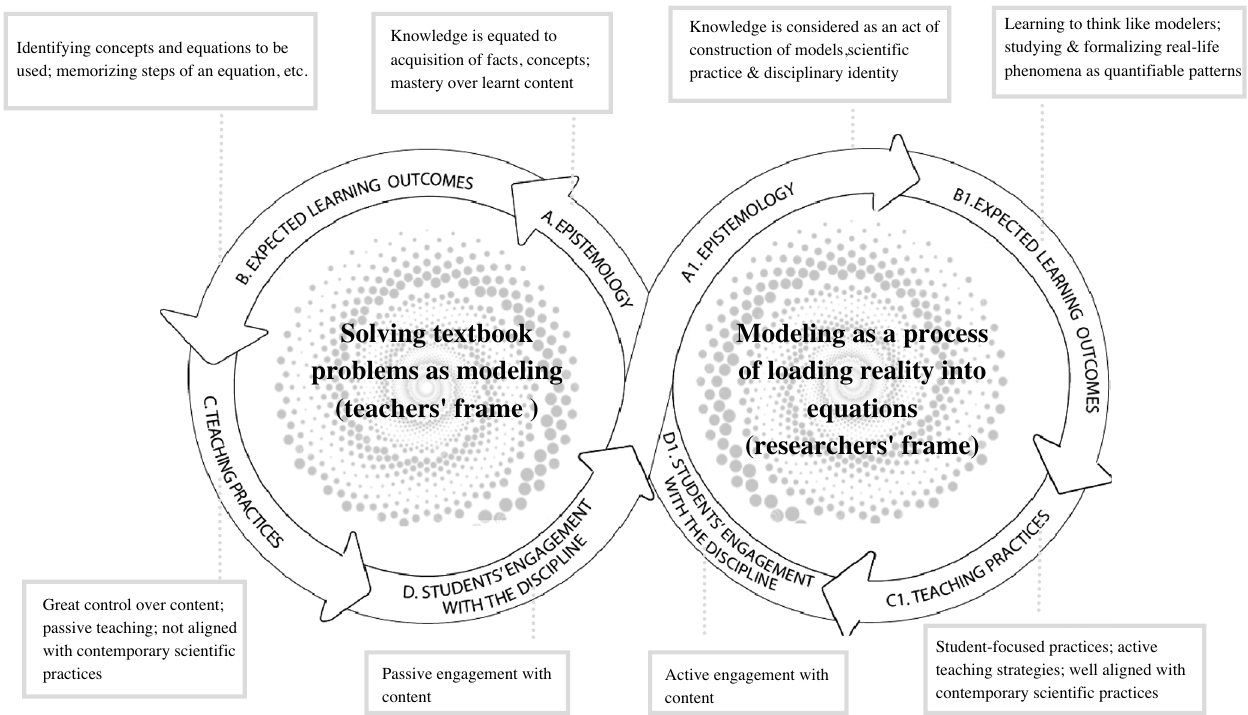
FIG. 11. The two circular structures capture the teachers ’ and researchers ’ epistemological frames in an integrated way — textbook problem solving as modeling, and modeling as a process of loading reality into equations, respectively. The spirals signify stability and local coherence in the activation of their respective epistemic resources. Note that this integration is driven by design considerations, and does not follow directly from the qualitative analysis